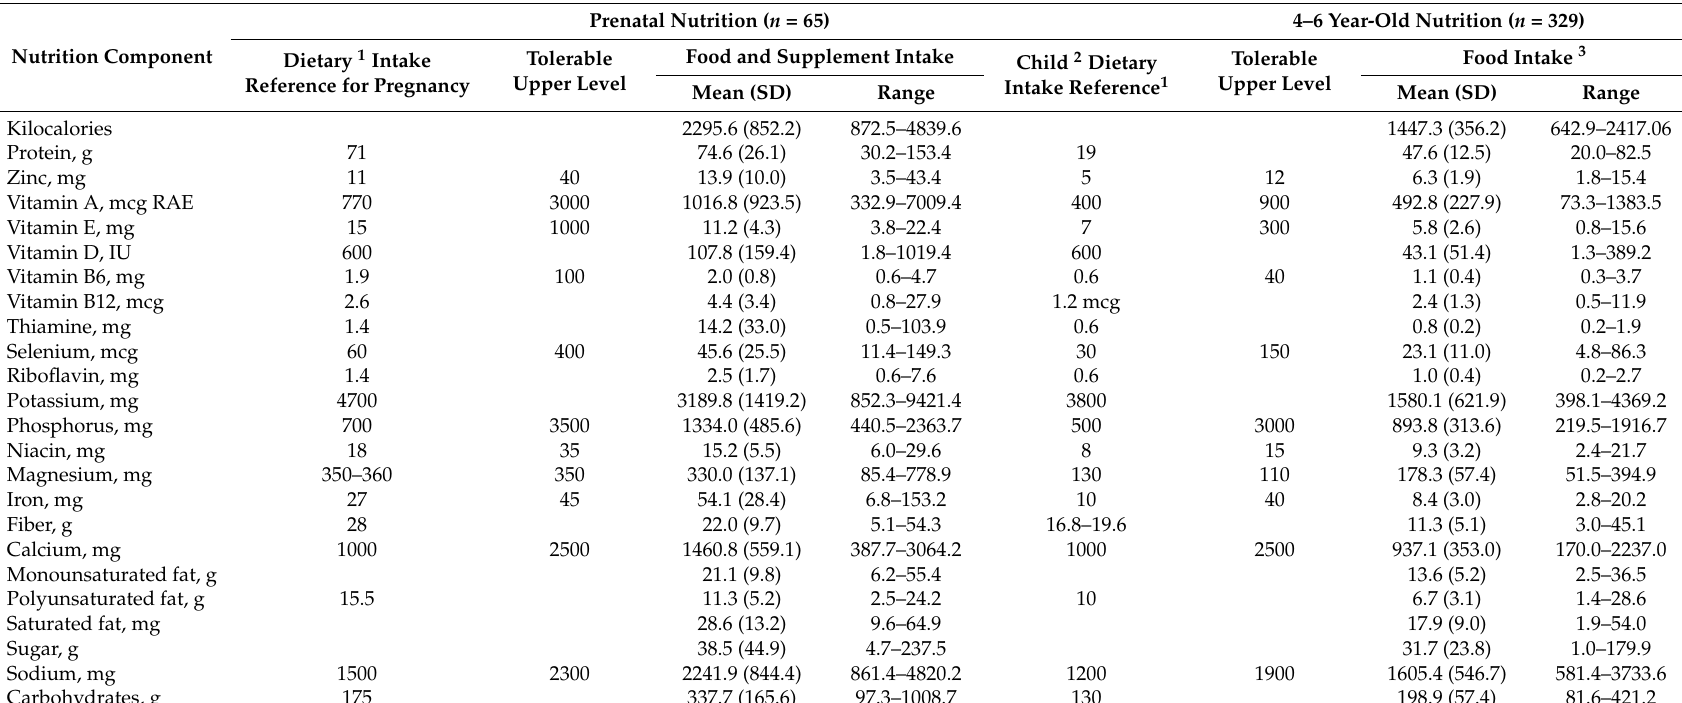
Table 2. Prenatal and childhood dietary intake with reference to U.S. dietary